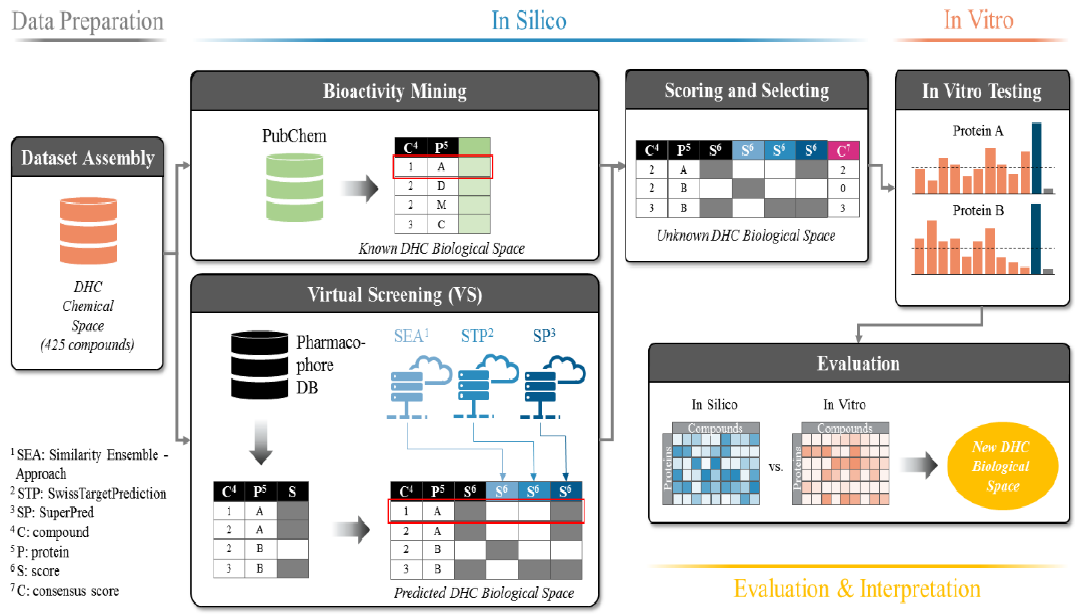
Figure 1. Workflow of the dihydrochalcone (DHC) target prediction campaign. The dataset is assembled (DHC chemical space) and used to retrieve corresponding bioactivity data from PubChem (known DHC biological space) and as input to inverse VS. First, the DHC chemical space is mapped onto the Pharmacophore DB (database) and the resulting matrix extended by the predictions of three individual target prediction servers: Similarity Ensemble Approach (SEA), SwissTargetPrediction (STP), and SuperPred (SP), resulting in the predicted DHC biological space. Activities already known from PubChem (the known DHC biological space) are then removed from the predicted DHC biological space, and the reduced matrix is scored according to the consensus predictions of the ligand-target interactions (unknown DHC biological space). Protein targets of the unknown DHC biological space are selected according to their consensus score (CS) and chosen for in vitro biological evaluation.